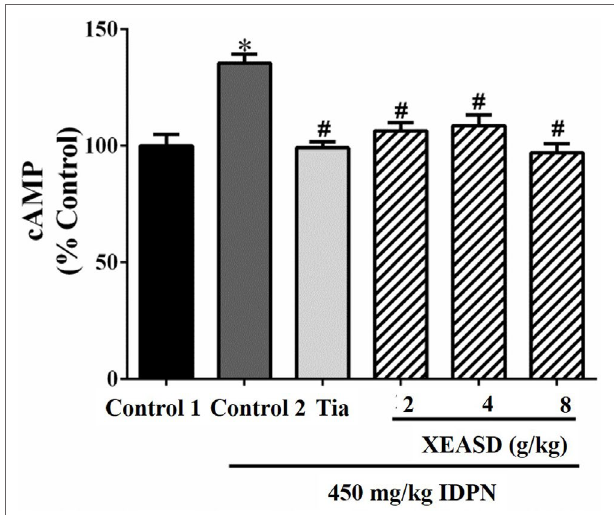
FIGURE 5 | Effects of XEASD treatment on plasma cAMP levels in IDPN- induced TS mice. Biochemical assay of plasma cAMP levels was performed as described in Materials and Methods. Control 1 represents normal control mice; control 2 represents IDPN-challenged control mice. Data are expressed as the percentage of non-challenged control 1 values. * P < 0.05, significantly different from the control 1; # P < 0.05, significantly different from the IDPN control 2. The value of cAMP level of control 1 (mean ± S.E.M.) = 0.50 ± 0.05 (pmol/mg protein).